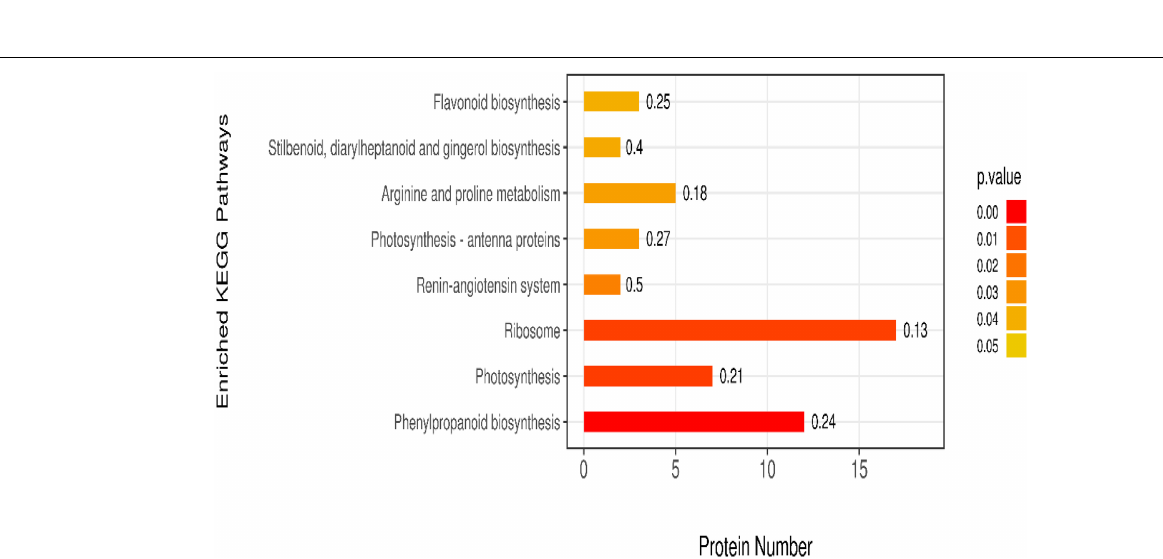
FIGURE 7 | Enrichment analysis of KEGG